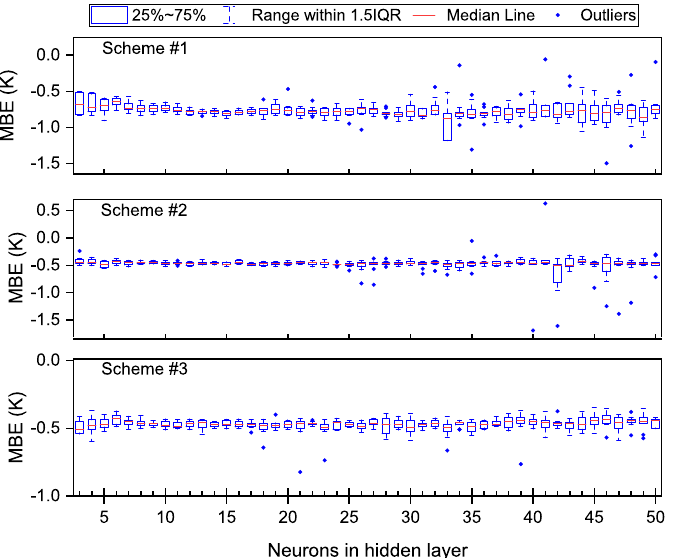
Figure 4. Mean bias error (MBE) of each training mission validated with radiosonde data from 2014 to 2015.